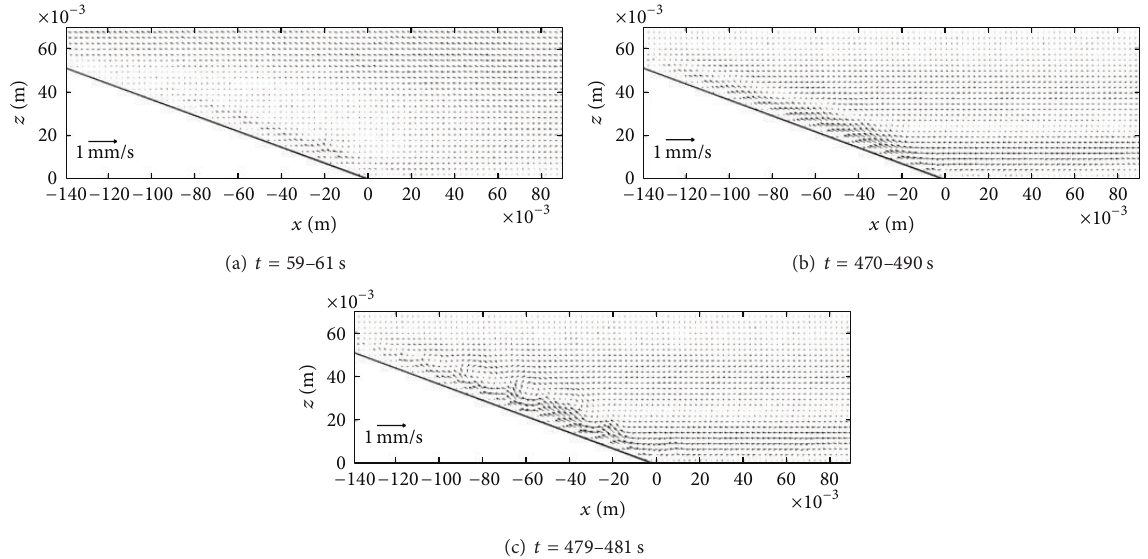
Figure 24: Mean velocity fields after (a) 60s (average over 2 s); (b) 480 s (average over 20 s); (c) 480 s (average over 2 s) from the beginning of experiment